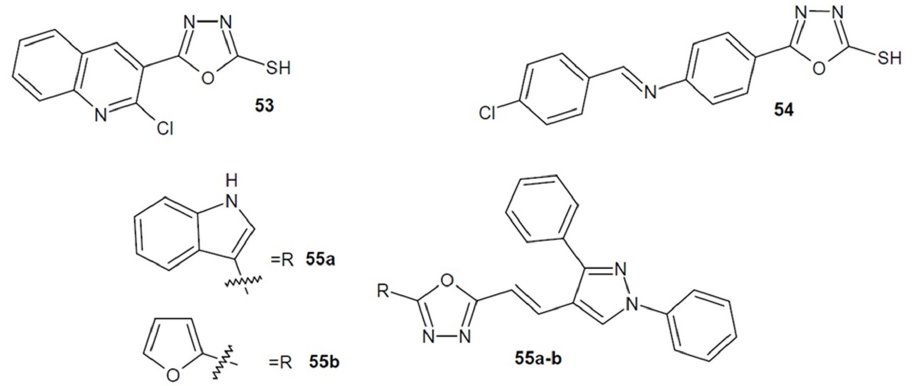
Figure 19. 1,3,4-oxadiazole derivatives with antimalarial